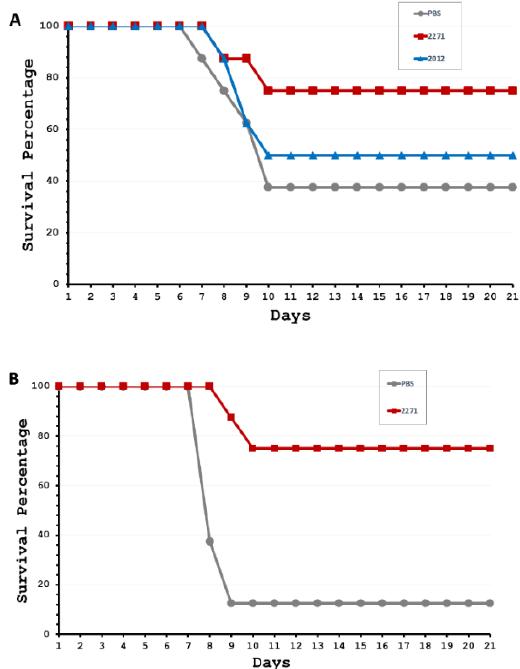
Figure 3. Survival of hamsters immunized with LRR proteins in two individual experiments (( A ); three experimental groups in experiment 1) and (( B ); two experimental groups in experiment 2) after challenge with the virulent L. interrogans serovar Pomona. The animals immunized with the rhKU_Sej_LRR_2012 (2012; blue line), the rhKU_Sej_LRR_2271 (2271; red line) proteins, and PBS as control (PBS; gray line) were challenged intraperitoneally with 2.5 × 10 2 leptospires (2.5 × modified LD50 [MLD50]) of a single passage of L. interrogans serovar Pomona (NVSL 11000-HL145A) in 1 mL of sterile PBS on 3 weeks after the 2nd immunization. The hamsters were monitored for mortality till day 21 post-challenge.